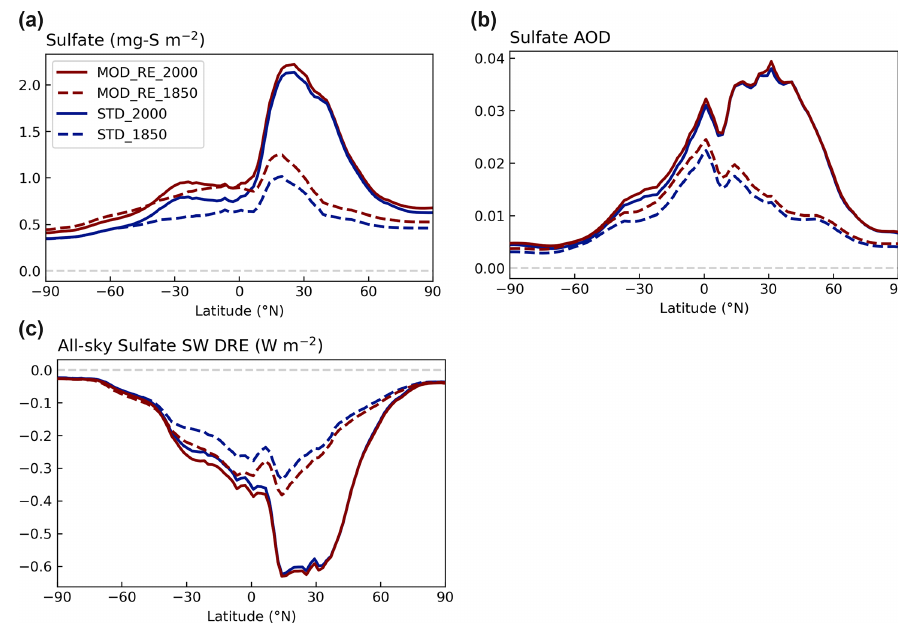
Figure 11. Contrasting the zonal means of (a) sulfate column concentration, (b) sulfate aerosol optical depth (AOD), and (c) all-sky SW sulfate DRE modeled with [MOD_RE] and [STD] chemistry at the PI and PD emission levels. Note that particulate MSA is included as sulfate in the MOD_RE simulations.